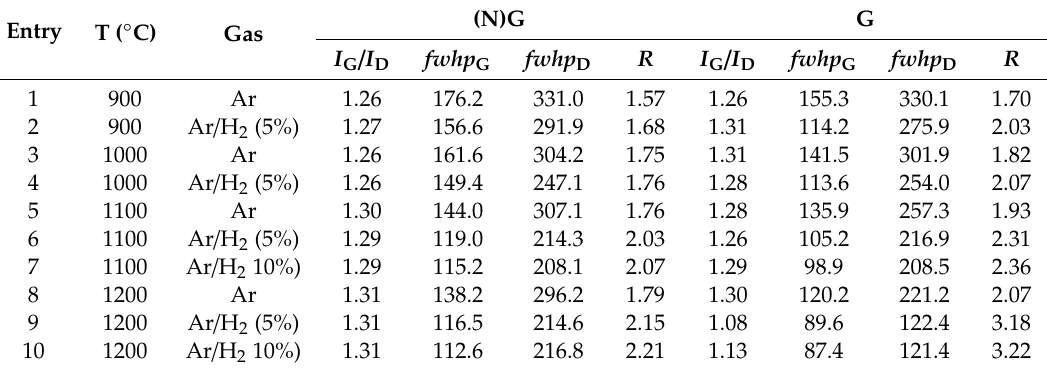
1 fwh p: full width at half peak height; R : resolution between the G and the D peak. The gray cells highlight the best values according to each quality indicator.